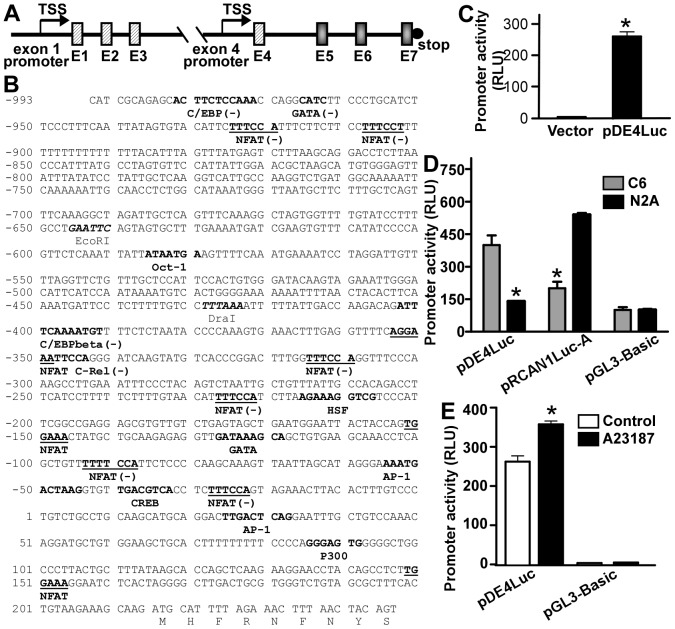
Two alternative promoters distinctly control RCAN1 expression.(A) Genomic organization of the RCAN1 gene. RCAN1 gene has seven exons and six introns. The first four exons are alternatively spliced and the last three exons are constitutive. There are two promoters and two translation initiation codons in the RCAN1 gene, in the 5′UTR of exon 1 and 5′UTR of exon 4 respectively. TSS, transcription start site. E stands for exon. (B) Human RCAN1 isoform 4 promoter sequence. A 1200 bp fragment of the 5′ flanking region of human RCAN1 exon 4 was amplified from a human genomic library. Thymine +1 represents the major transcription start site. Positions of some of the unique and common restriction enzymes are indicated in italics and boldface. Putative transcription factor binding sites are underlined in boldface. The codon of the first nine amino acids of exon 4 is indicated. (C) 1200-bp fragment upstream of the exon 4 had significant promoter activity. 1200-bp fragment upstream of the exon 4 was cloned into pGL3-Basic to generate the pDE4Luc luciferase reporter plasmid. pDE4Luc was transfected into HEK293 cells. pGL3-Basic was used as negative control. Luciferase activity was measured 24 hours after transfection. Values represent means ± SE (n = 4), *P<0.05 by student's t-test. (D) Compared to the RCAN1 exon 1 promoter pRCAN1Luc-A, RCAN1 exon 4 promoter pDE4Luc had a higher promoter activity in C6 cells but a lower activity in N2A cells. RCAN1 promoter constructs pDE4Luc and pRCAN1Luc-A were transfected into C6 and N2A cells. pGL3-Basic was used as negative control. Luciferase activity was measured 24 hours after transfection by a luminometer. Renilla luciferase activity was used to normalize transfection efficiency. Values represent means ± SE (n = 4), *P<0.05 by student's t-test. (E) Calcium ionophore A23187 significantly increased pDE4Luc activity. HEK293 cells transfected with pDE4Luc were treated with 2.5 µM A23187 for 12 hours. Luciferase assay was used to measure the promoter activity. pGL3-Basic was used as negative control. Renilla luciferase activity was used to normalize transfection efficiency. Values represent means ± SE (n = 4), *P<0. 05 by student's t-test.